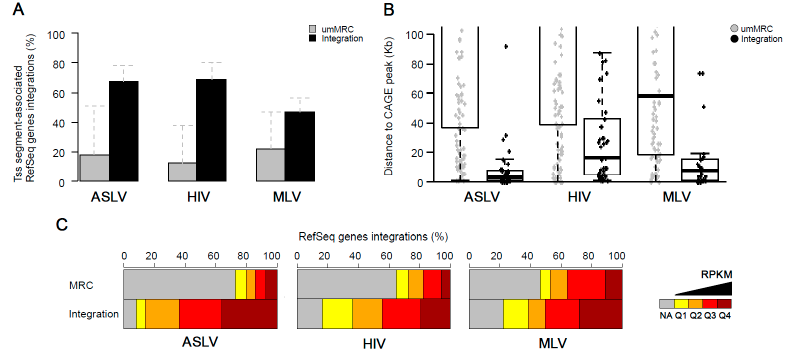
Figure 4. Transcriptionally active genes targeted by proviral integrations. ( A ) Percentage of proviruses identified inside RefSeq Genes associated with Tss chromatin state marking active TSS. Dashed whiskers show the original percentages of proviruses inside RefSeq Genes without selection for the presence of the Tss chromatin state. ( B ) Distance of proviruses to cap analysis of gene expression (CAGE) peaks that mark the site of active TSS. ( C ) Transcriptional activity of genes with proviruses. Genes were classified into 5 groups according to their mean read per kilobase per million (RPKM) mapped reads. NA marks group with no or very low transcriptional activity. Q1 to Q4 groups contain the genes with RPKM ≥ 1, where Q1 group represents the lowest quartile and Q4 the highest quartile.